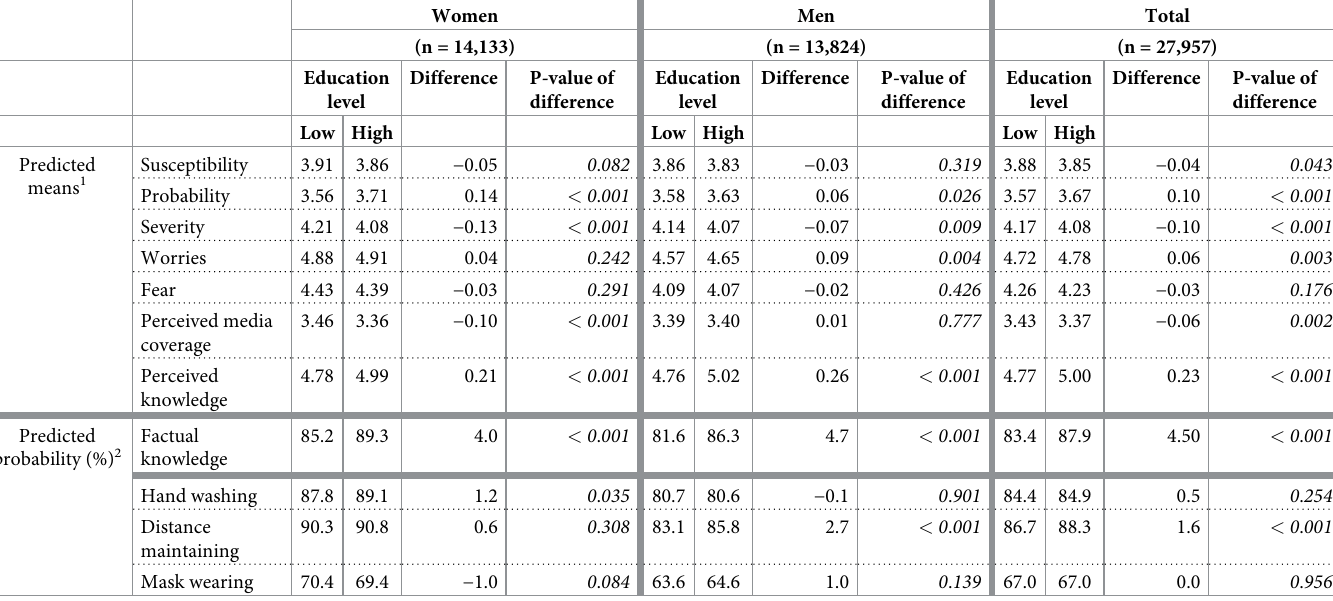
Table 2. Risk perception, perceived media coverage, knowledge and protective behaviour in women and men with different education